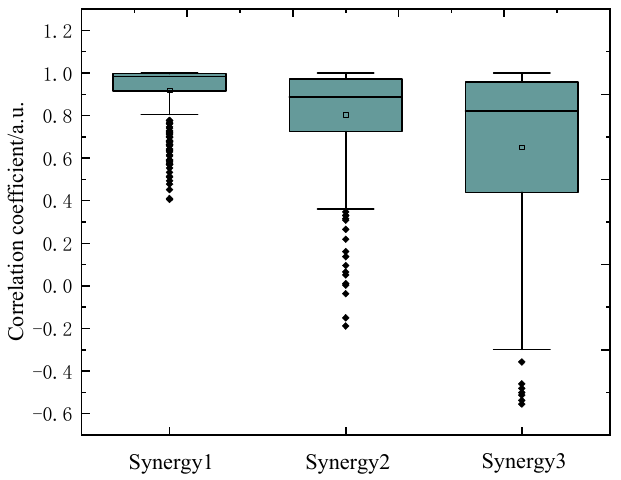
Figure 5. The boxplots of the correlation coefficients of muscle synergies extracted from a typical trial data of healthy subject using NMF.